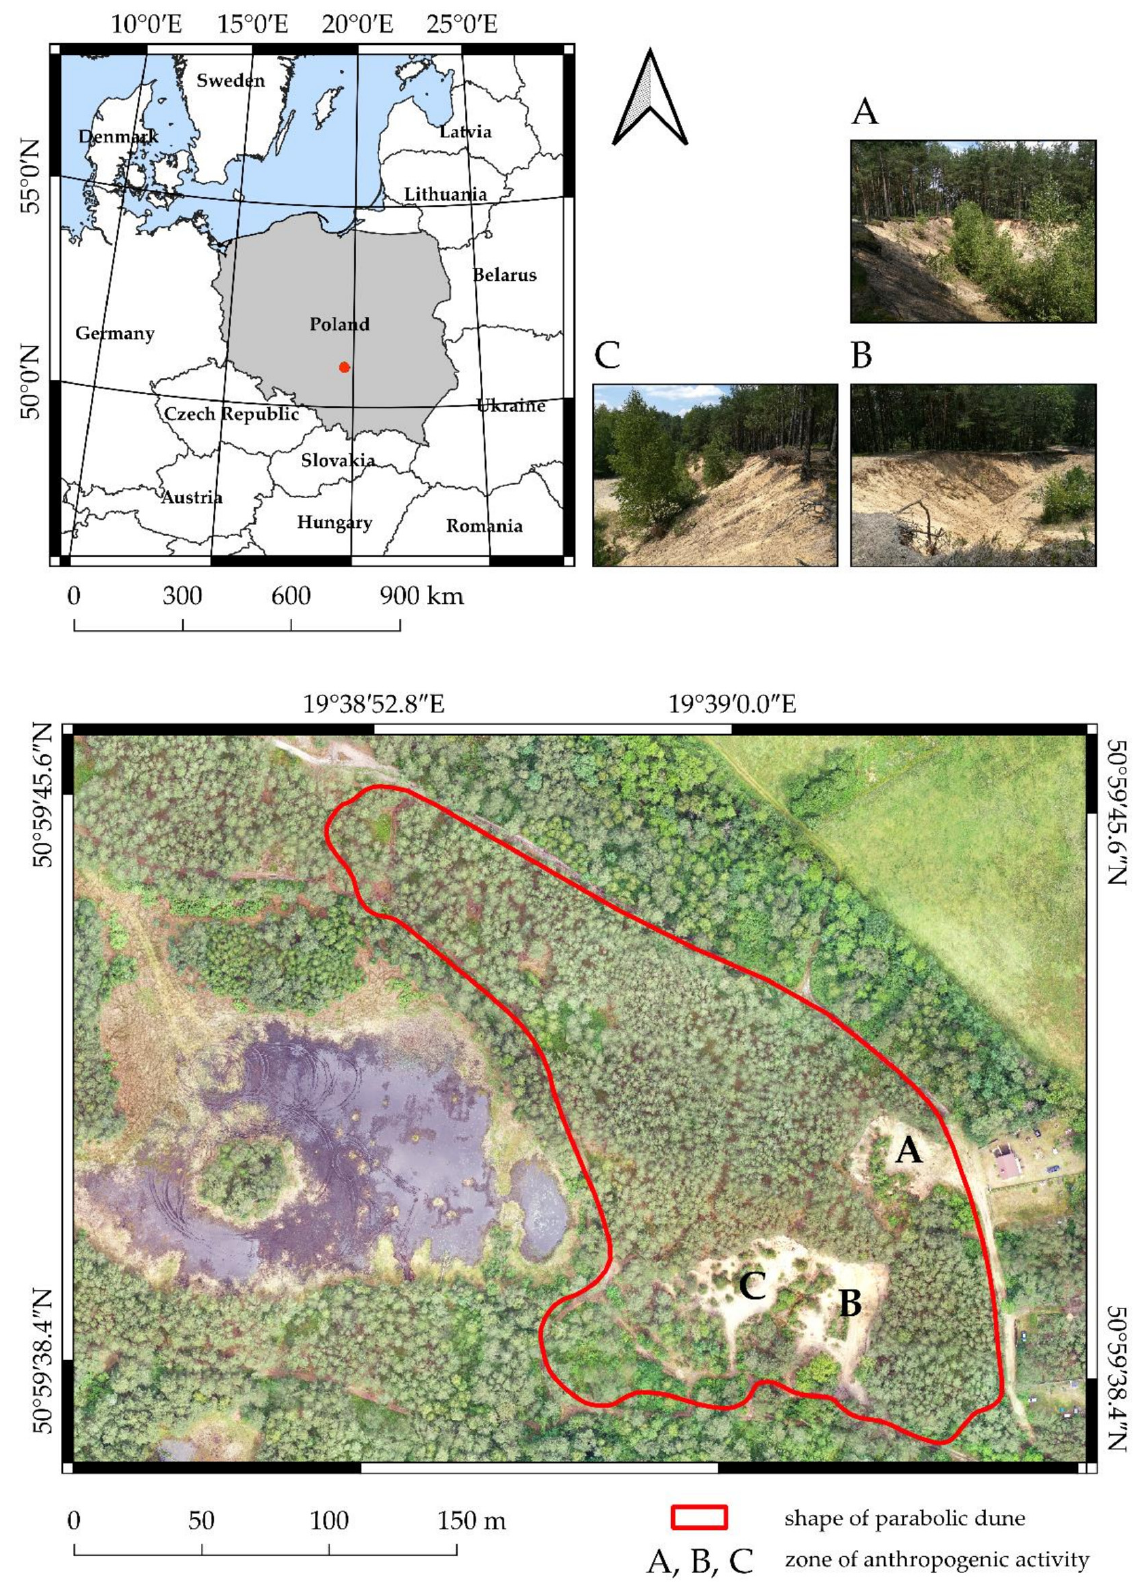
Figure 1. The parabolic dune and its surroundings, as located against the background of Poland and Europe; human activity related to sand exploitation: side views and overhand views: A —eastern slope; B , C —southern slope